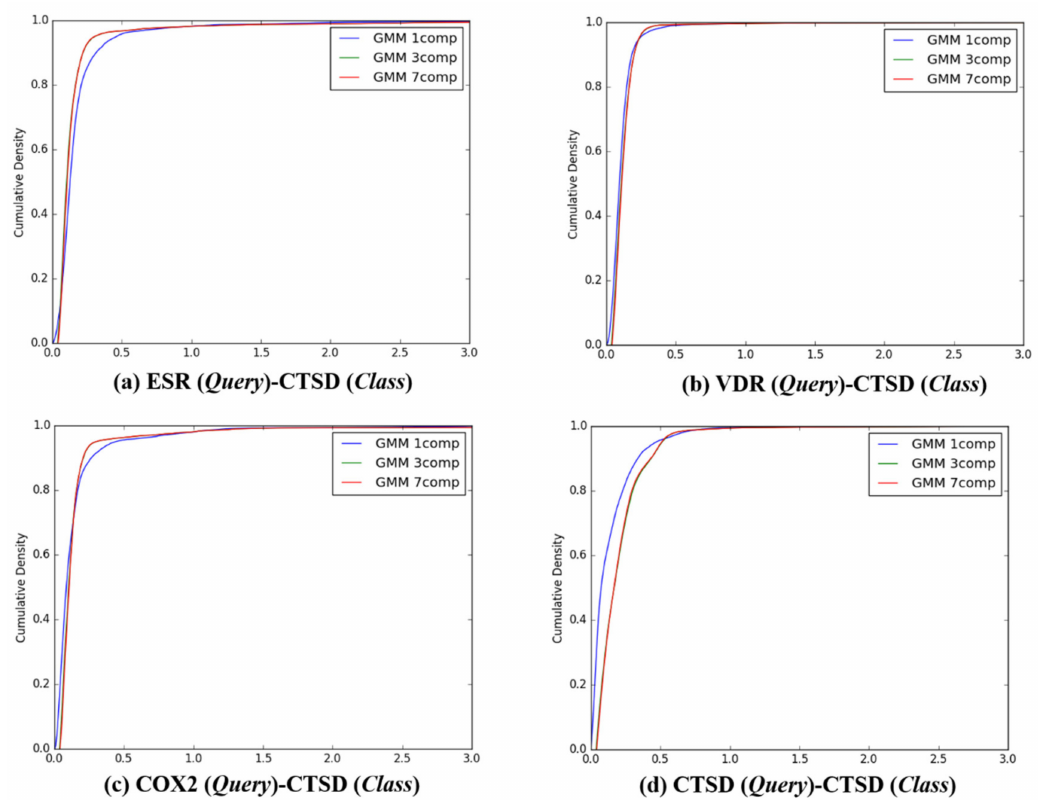
Figure 7. The cumulative densities of K–L distance between Q -distribution (Target class: CTSD) and queries. X -axis: K–L divergence, Y -axis: cumulative density; Q -distribution of CTSD through GMM and the distribution of queries were calculated. ( a ) ESR(Query)-CTSD(Class), ( b ) VDR(Query)-CTSD(Class), ( c ) COX2(Query)-CTSD(Class), and ( d )